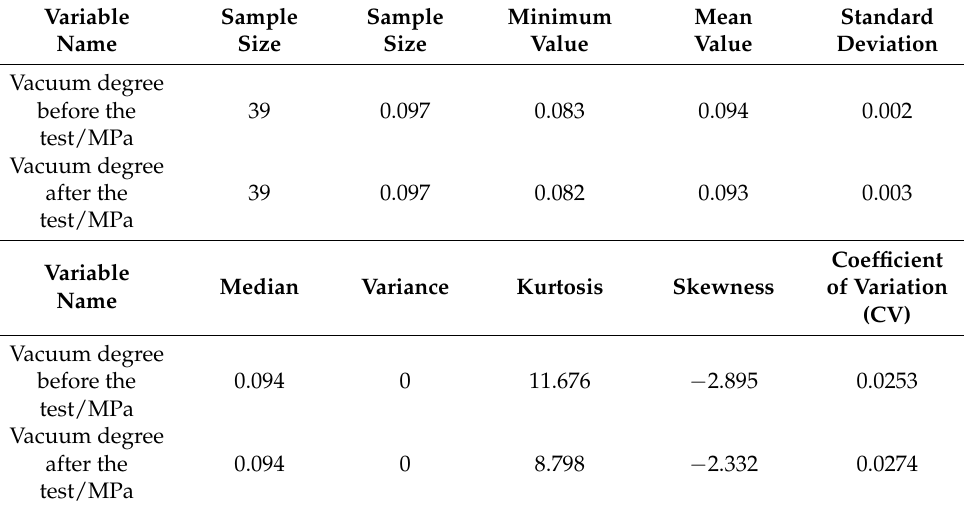
Table 3. Results of descriptive statistics of vacuum degree before and after 12,000 fatigue